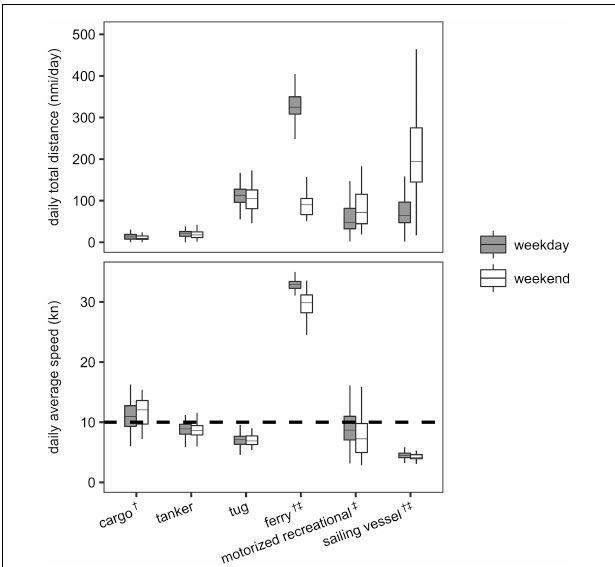
FIGURE 6 | Daily distance (nmi/day) (top) and average speed (kn) (bottom) by weekday/weekend for each vessel class. Box and whisker plots show sample minimum, maximum, median, and first and third interquartile values. Outliers are not shown. Statistically significant differences in median daily distance between seasons denoted by † ( p < 0.01). Statistically significant differences in median speed between weekday/weekend denoted by ‡ ( p < 0.01). Dashed line indicates 10-kn voluntary speed restriction used in National Marine Sanctuaries outside San Francisco Bay (United States Coast Guard [USCG], 2017). Sample sizes: n 1 = 118 days (weekdays), n 2 = 57 days (weekends).